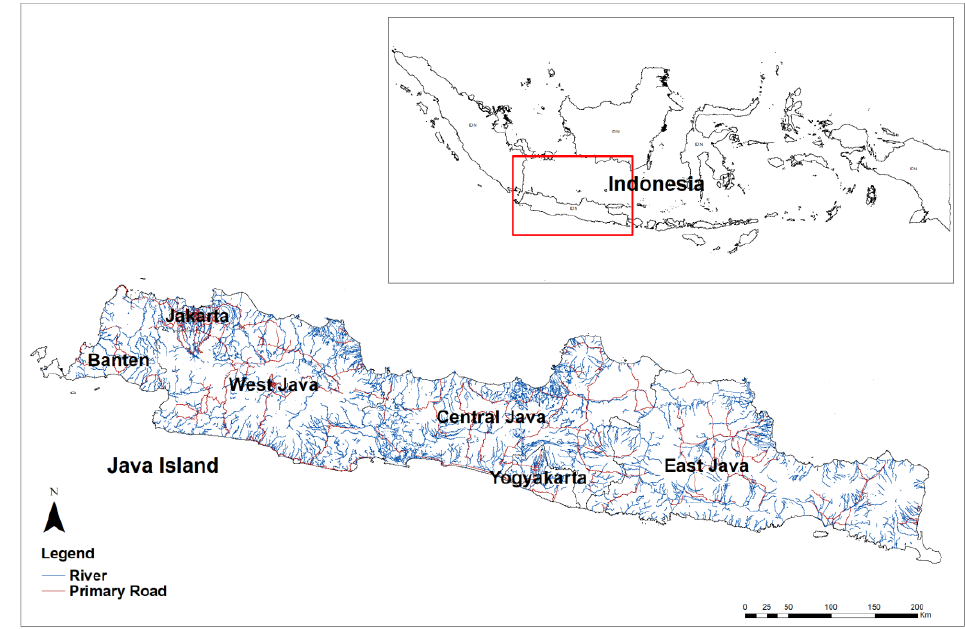
Figure 1. Study area.